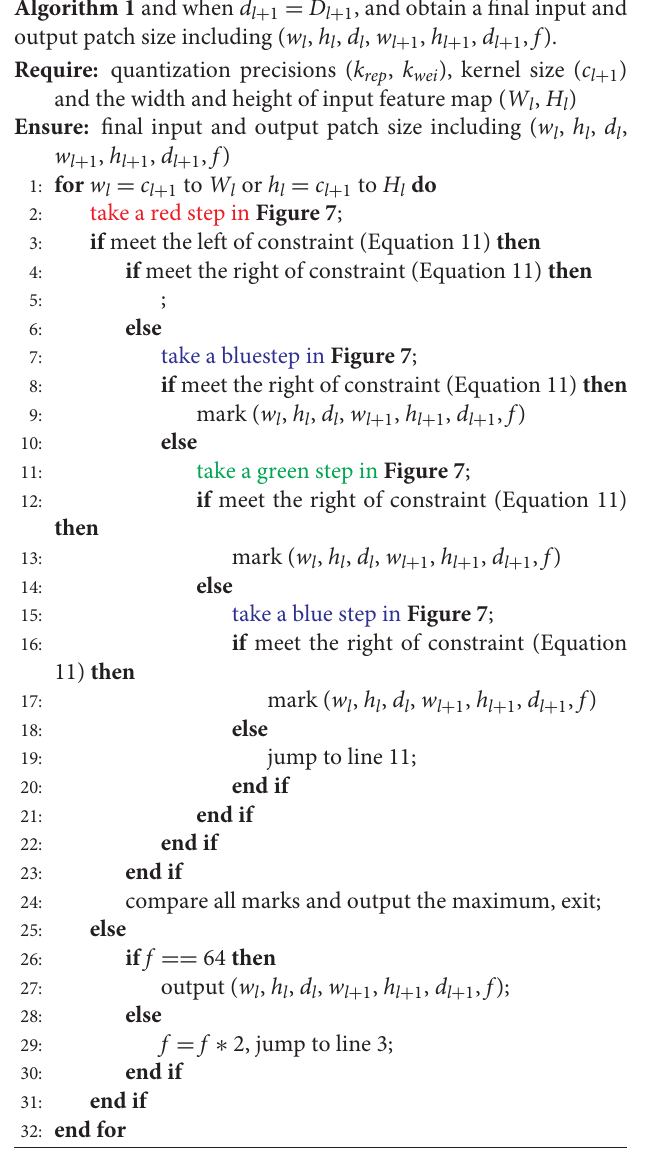
Algorithm 2 Square-major search. This is the second procedure that should be executed after Algorithm 1 and when d l + 1 = D l + 1 , and obtain a final input and